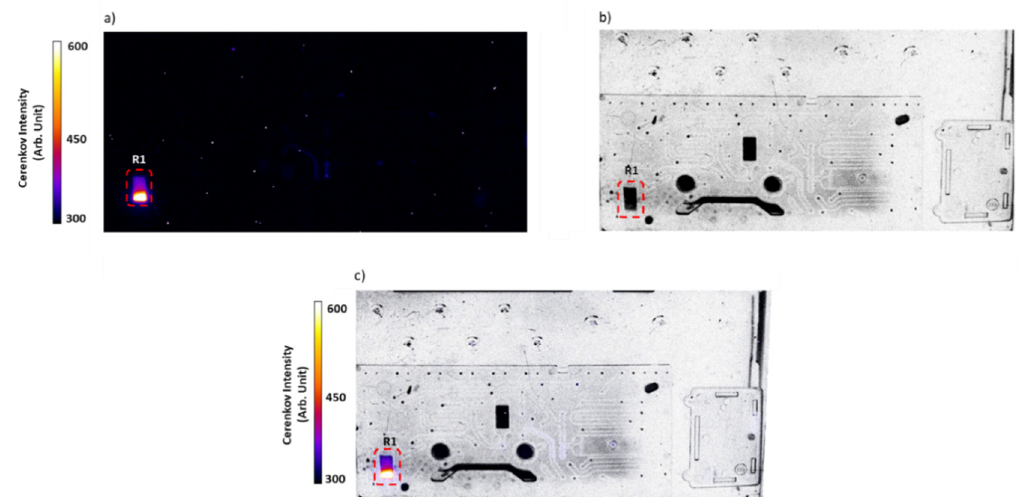
Figure 4. Cerenkov imaging of the residual activity distribution on the cassette after single production of [ 68 Ga]Ga-citrate on R1 chamber with PS-H+ beads; ( a ) Cerenkov image after synthesis; ( b ) white-light image of the top of the cassette; ( c ) merged Cerenkov and white-light images after completion of the synthesis.